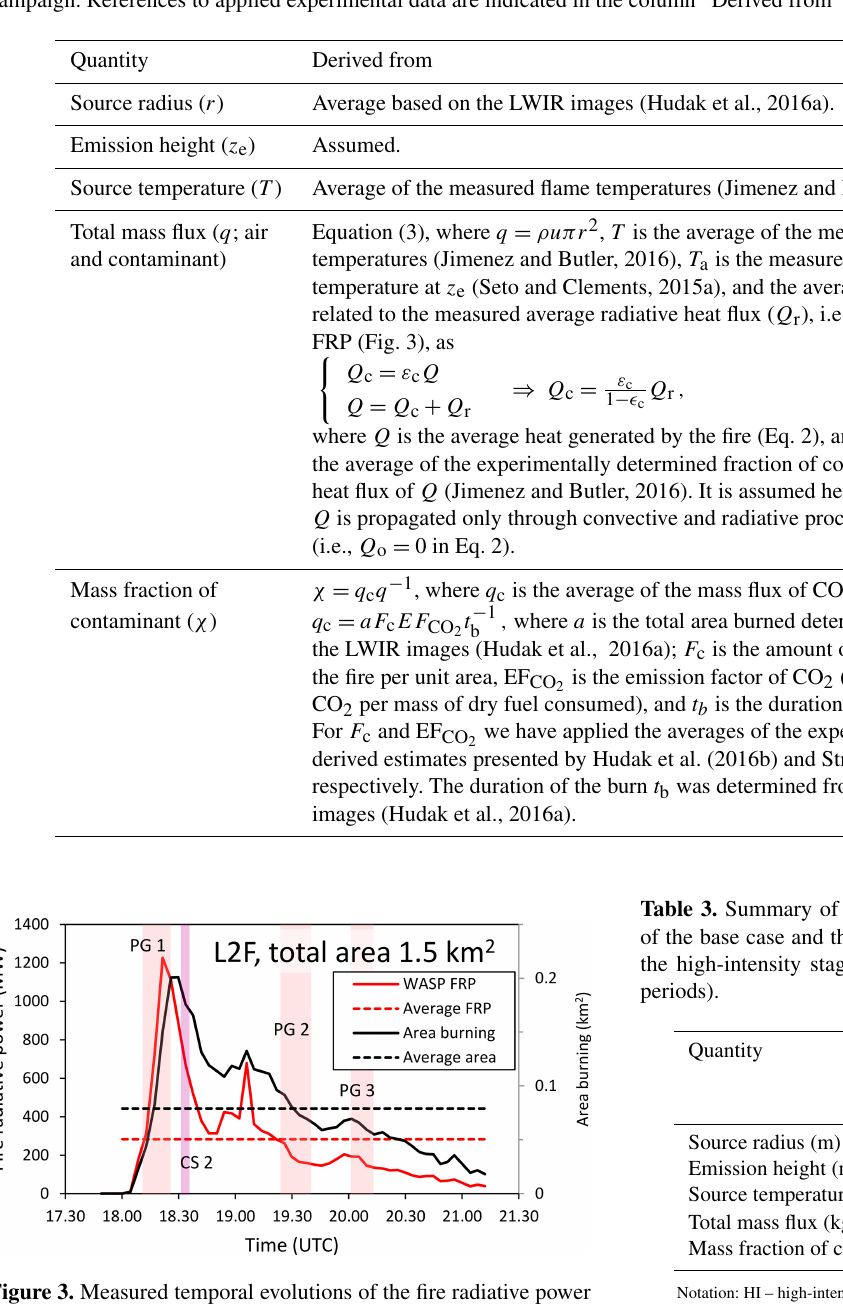
Table 2. Summary of the fire source information required by the BUOYANT model related to the L2F burn of the RxCADRE experimental campaign. References to applied experimental data are indicated in the column “Derived from”.